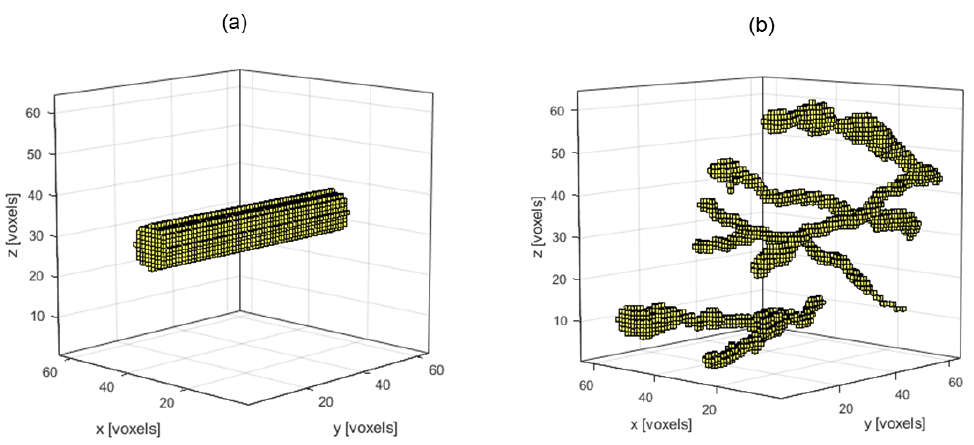
Figure 4. ( a ) The base case cylindrical IPD and ( b ) an example of a vessel-like